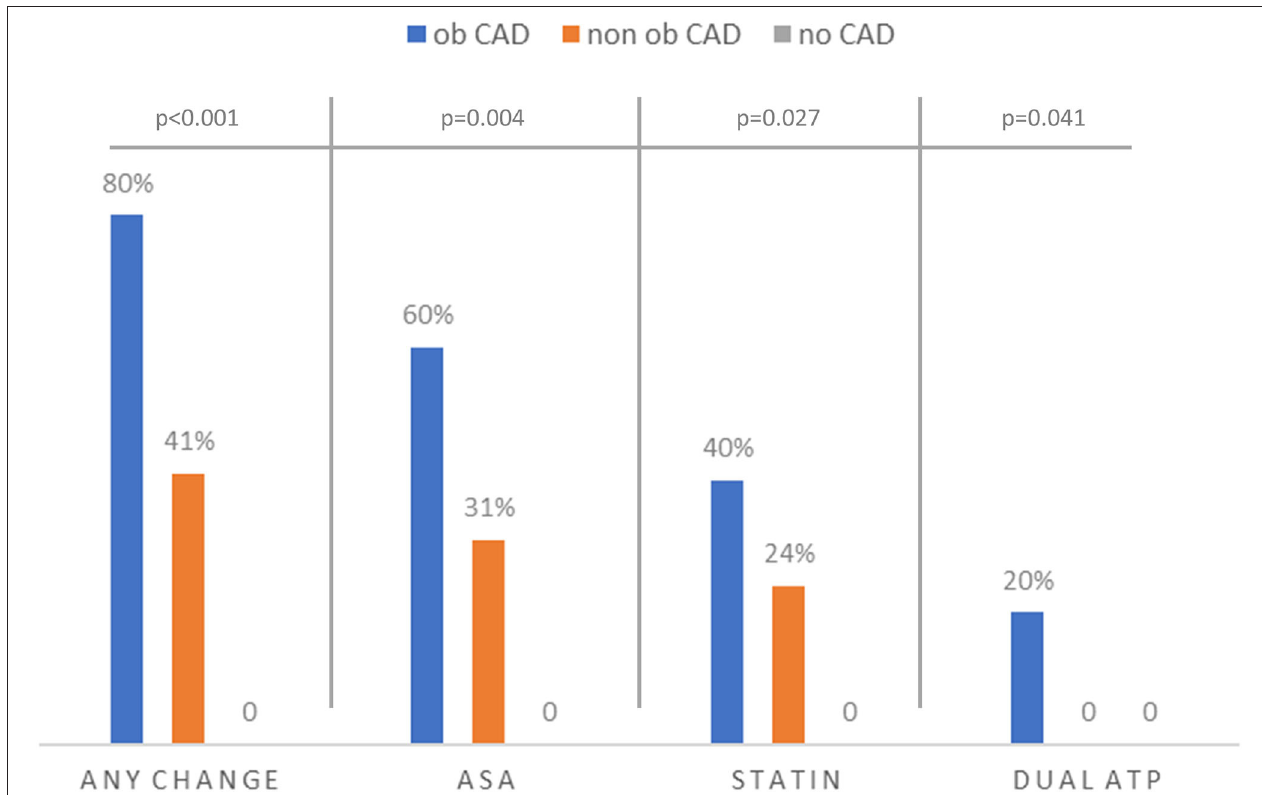
FIGURE 3 | Prevalence of medical therapy changes according to CCTA findings among patients who did not undergo ICA. Of note, no new drugs were introduced by the referring physician in patients who were free of coronary atherosclerosis, while a significantly higher rate of aspirin and statin new prescriptions was observed when non-obstructive or obstructive CAD was identified at CCTA. Ob CAD, obstructive CAD; non-ob CAD, non-obstructive CAD; CAD, coronary artery disease; DAPT, dual antiplatelet